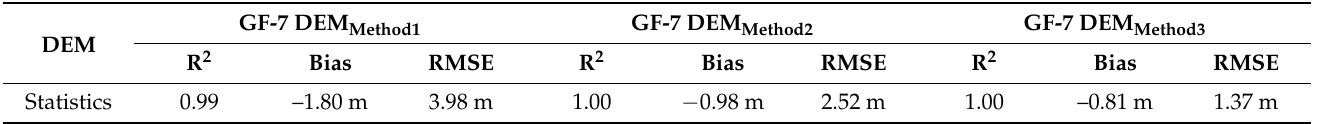
Figure 14. Horizontal offsets and errors of H1–H13 measured by the airborne LiDAR DEM, GF-7 DEM Method1 , GF-7 DEM Method2 and GF-7 DEM Method3 . Table 5. Statistics of the horizontal offsets measured by the airborne LiDAR-derived DEM and the GF-7